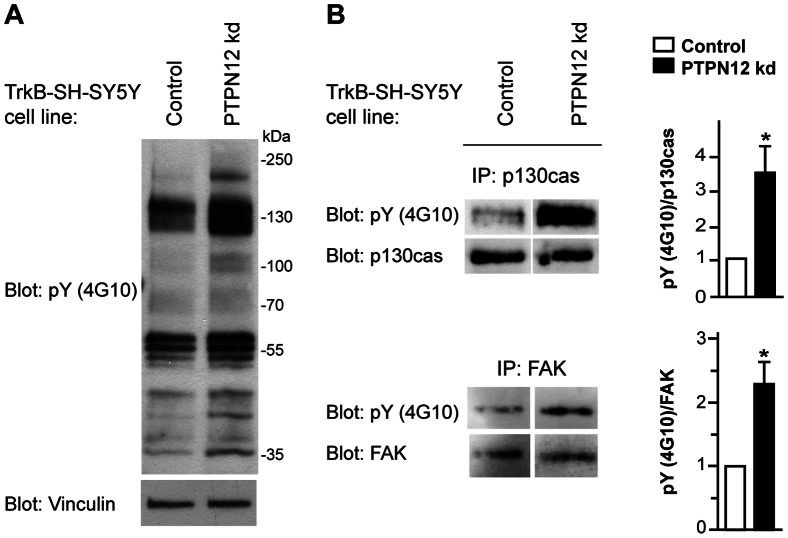
PTPN12 changes the phosphotyrosine profile in TrkB-SH-SY5Y cells.A) Total phosphotyrosine pY levels (4G10 antibody) were revealed by western blotting in lysates from control or PTPN12 kd cells cultured for 24 h and starved for 4 h prior to lysis (basal condition). Vinculin served as loading reference. B) Lysates prepared from cells as in A) were immunoprecipitated (IP) using p130cas or FAK antibodies and blotted for total pY levels (4G10 antibody). Total p130cas and FAK levels were used as the respective references. Densitometric quantification of the tyrosine phosphorylation level of p130cas and FAK (4G10), compared to total p130cas and FAK levels, is shown as mean and S.E.M. of three and five independent experiments respectively, with values normalized to the control. Statistical analysis was performed using Student’s paired t-test (*: p≤0.05).